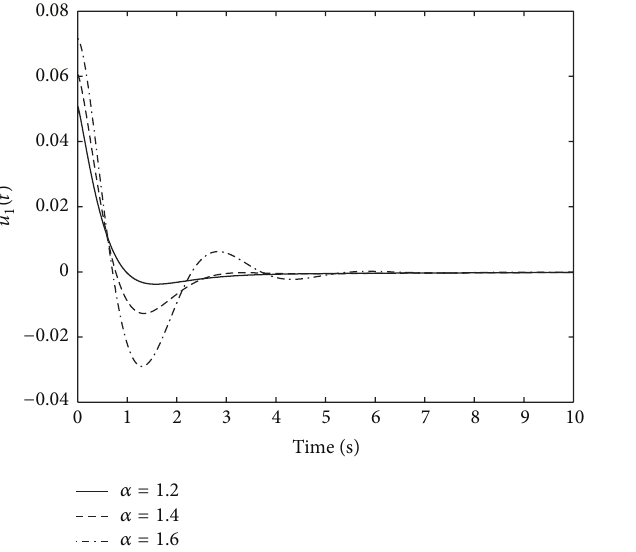
Figure 4: Control input 𝑢 1 (𝑡) (1 ≤ 𝛼 < 2) .